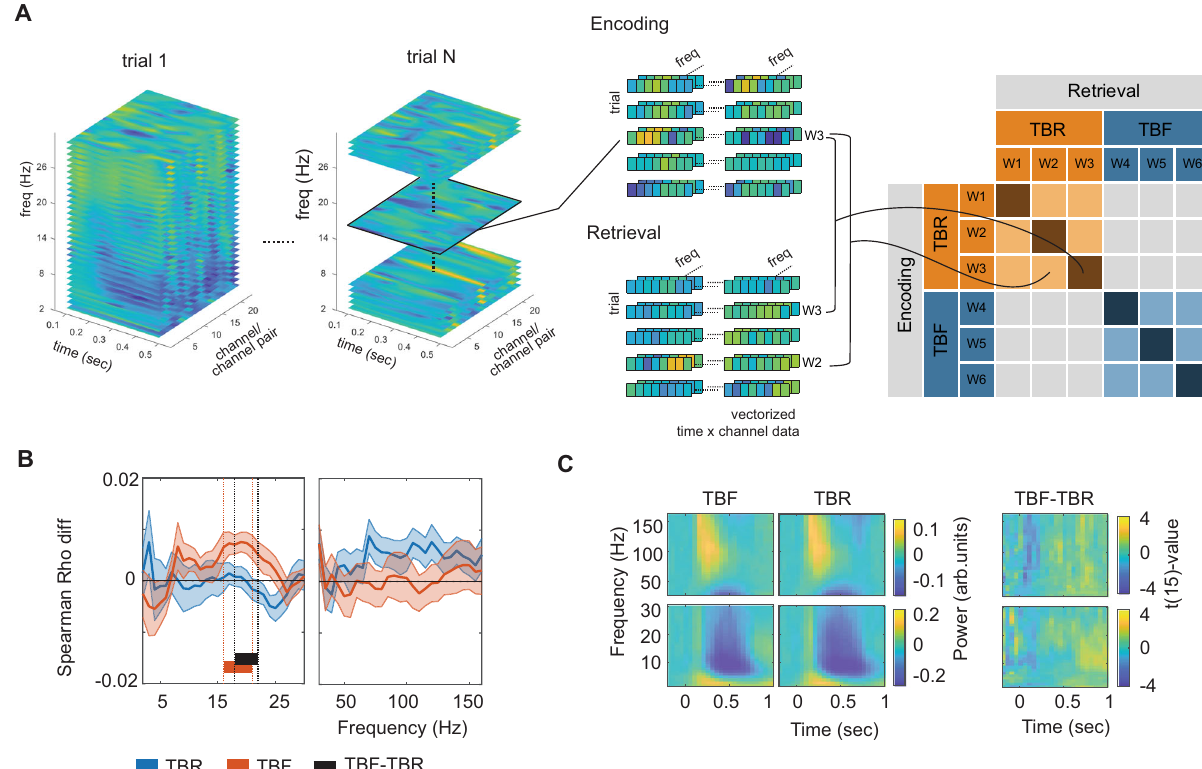
Fig. 3 Voluntary forgetting modi fi es but does not remove item-speci fi c memory traces. A Encoding-retrieval similarity analysis pipeline. Time-frequency patterns were extracted from all LTC electrodes, and matrices of time points x channels (or channel pairs for coherence analyses) were built, separately for each frequency bin. Encoding-retrieval similarities were compared between same (diagonal) and different (off-diagonal) words (W) at encoding and retrieval in order to identify item-speci fi c activations. We computed Spearman ’ s correlations for to-be-remembered (TBR) and to-be-forgotten (TBF) words separately, and also separately for items that were actually remembered and forgotten (see Fig. 4). B Encoding-retrieval similarity of distributed activity patterns across lateral temporal cortex channels based on power for to-be-remembered (TBR) and to-be-forgotten (TBF) words, irrespective of subsequent memory. Shaded error bars indicate the standard error of the mean ( n = 16). Blue, orange, and black lines indicate signi fi cant clusters for item- speci fi c activation of TBR items, TBF items, and the difference between TBR versus TBF items, respectively. C Time-frequency responses for TBR and TBF items during retrieval. No signi fi cant differences were found. Source data are provided as a Source Data fi signi fi cant item-speci fi c ERS for TBF (135 – 160 Hz and